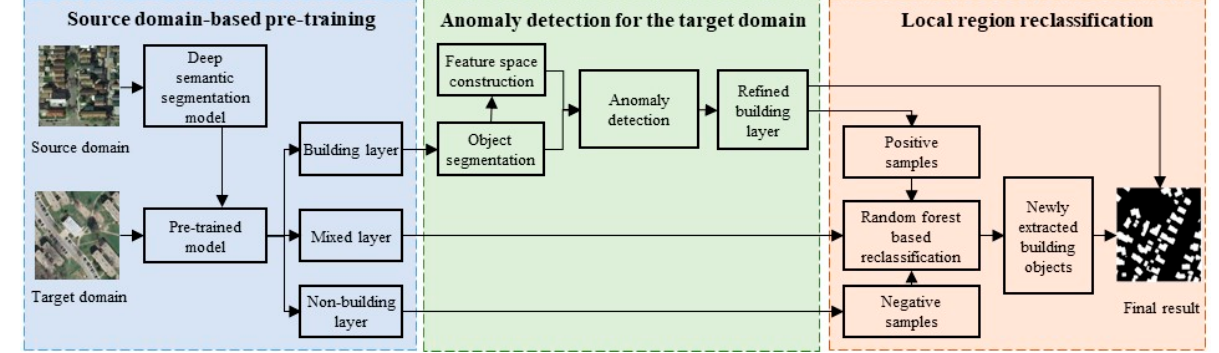
Figure 1. Overall architecture of our anomaly detection-based domain adaptation